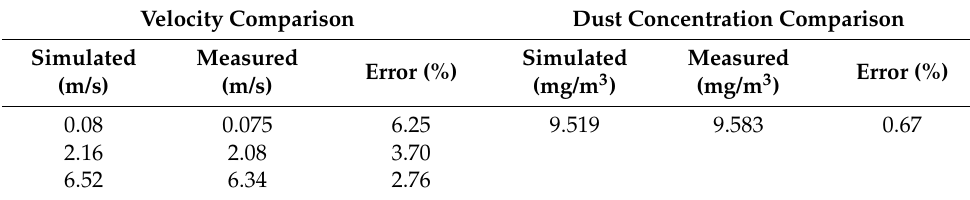
Table 2. Comparison of simulation results and experimental data.